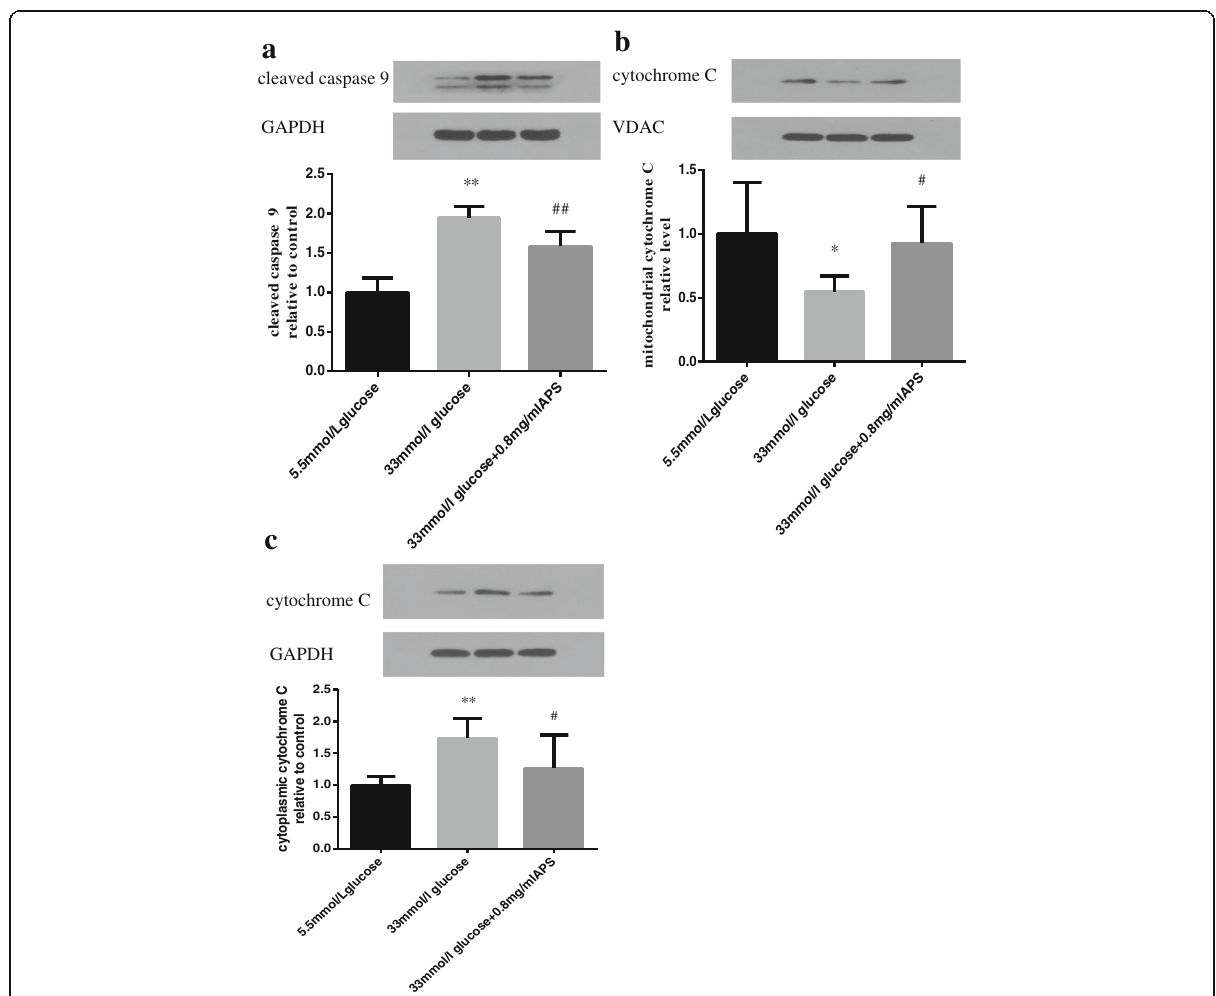
Fig. 8 APS modulated apoptosis-related proteins in the intrinsic pathways. H9C2 cells were pre-incubated with/without APS for 24 h and then treated with 33 mmol/L glucose for 24 h. The expression of GAPDH was measured as an internal control for the cytoplasmic fraction. The expression of VDAC was measured as an internal control for the mitochondrial fraction. a . Semi-quantitative expressions of cleaved caspase 9 in different groups. b . Semi-quantitative expressions of mitochondrial cytochrome C in different groups. c . Semi-quantitative expressions of cytoplasmic cytochrome C in different groups. Data were expressed as Mean ± SD. * P < 0.05 versus 5.5 mmol/L glucose group; ** P < 0.01 versus 5.5 mmol/L glucose group; # P < 0.05 versus 33 mmol/L glucose group; ## P < 0.01 versus 33 mmol/L glucose